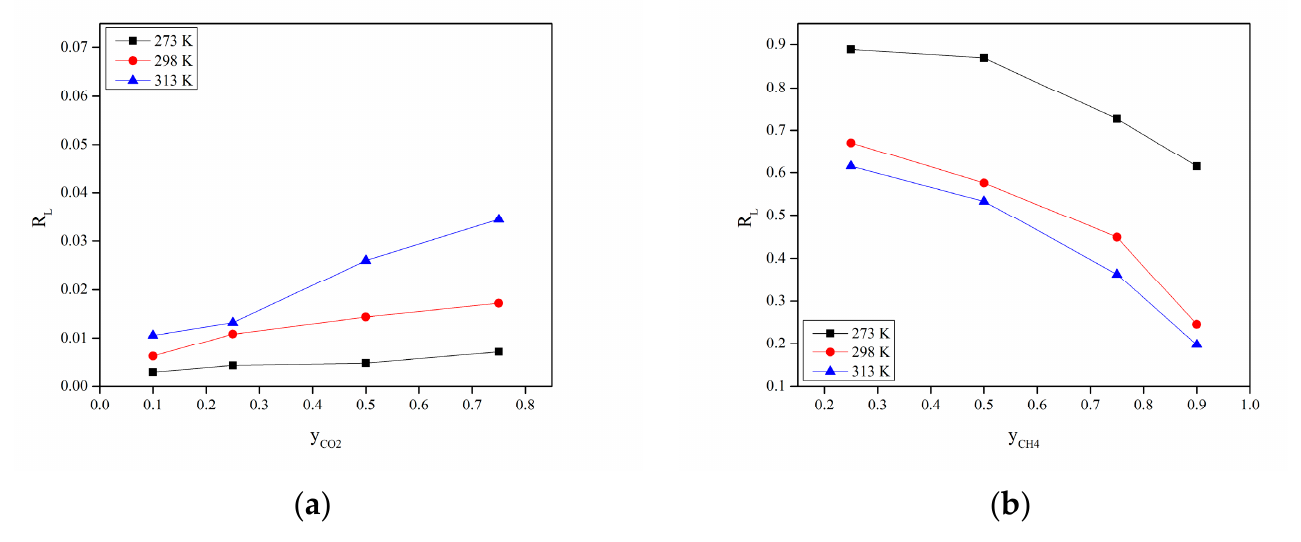
Figure 11. R L of: ( a ) CO 2 ; ( b ) CH 4 at 273, 298 and 313 K.